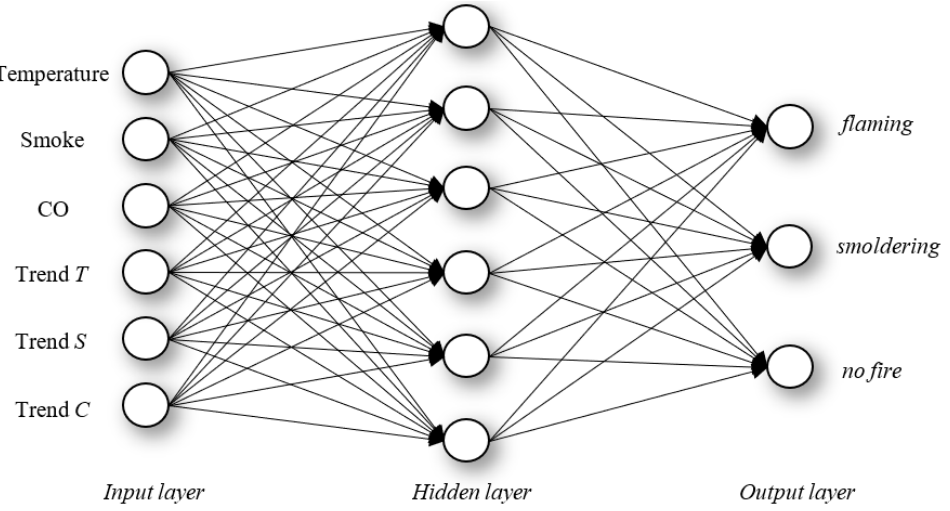
Figure 4. The fusion model of the back propagation neural network.